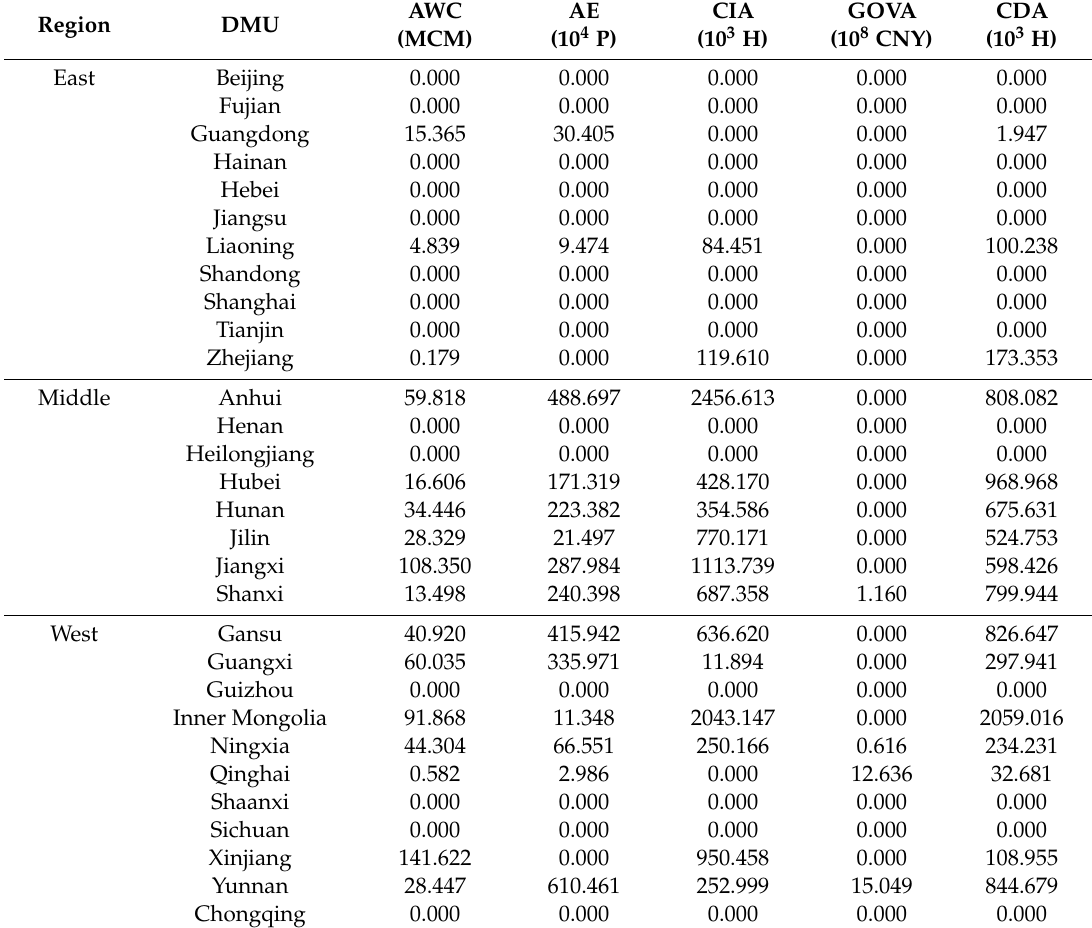
Table 6. Improvement value of the input–output